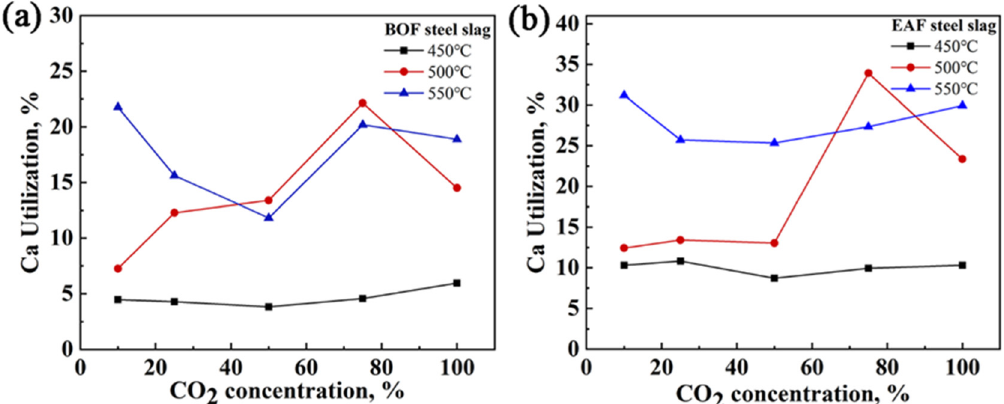
Figure 7. Variation of Ca utilization with the CO 2 concentration for BOF steel slag and EAF steel slag. ( a ) BOF slag; ( b ) EAF slag [115], adapted from [115], with permission from ACS, 2021.